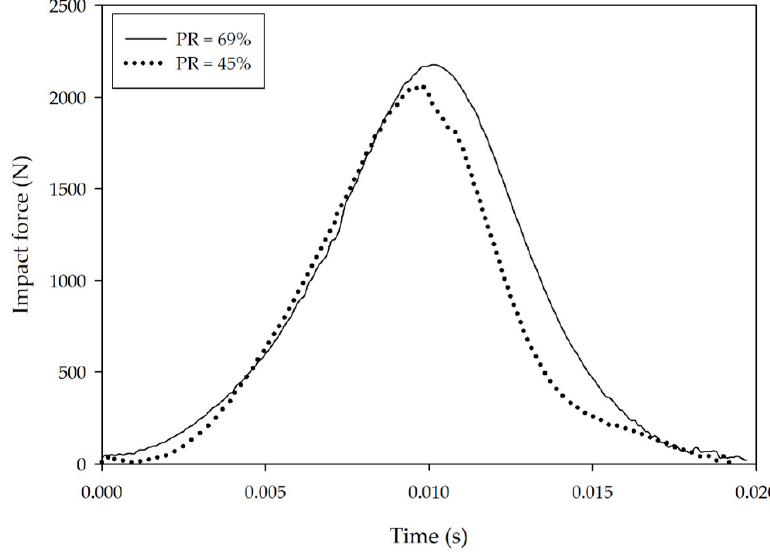
Figure 6. Force-time diagrams of two vulcanized rubbers possessing comparable hardness levels but differing in PR (see legend) evaluated at an impact energy of 6 J . Accompanying slow-motion video reveals that the strain in each case is similar (~60%).